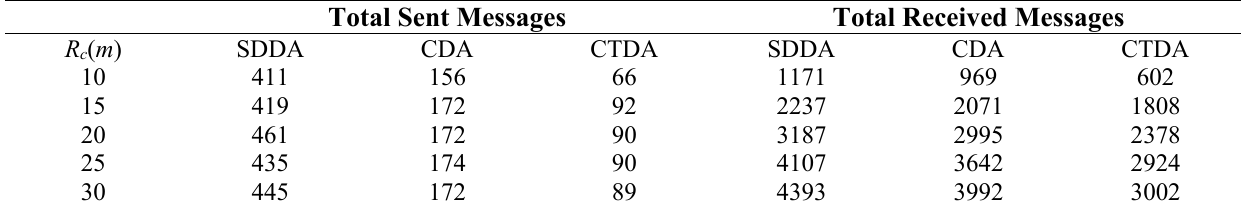
Table 2. Total messages with various communication ranges.